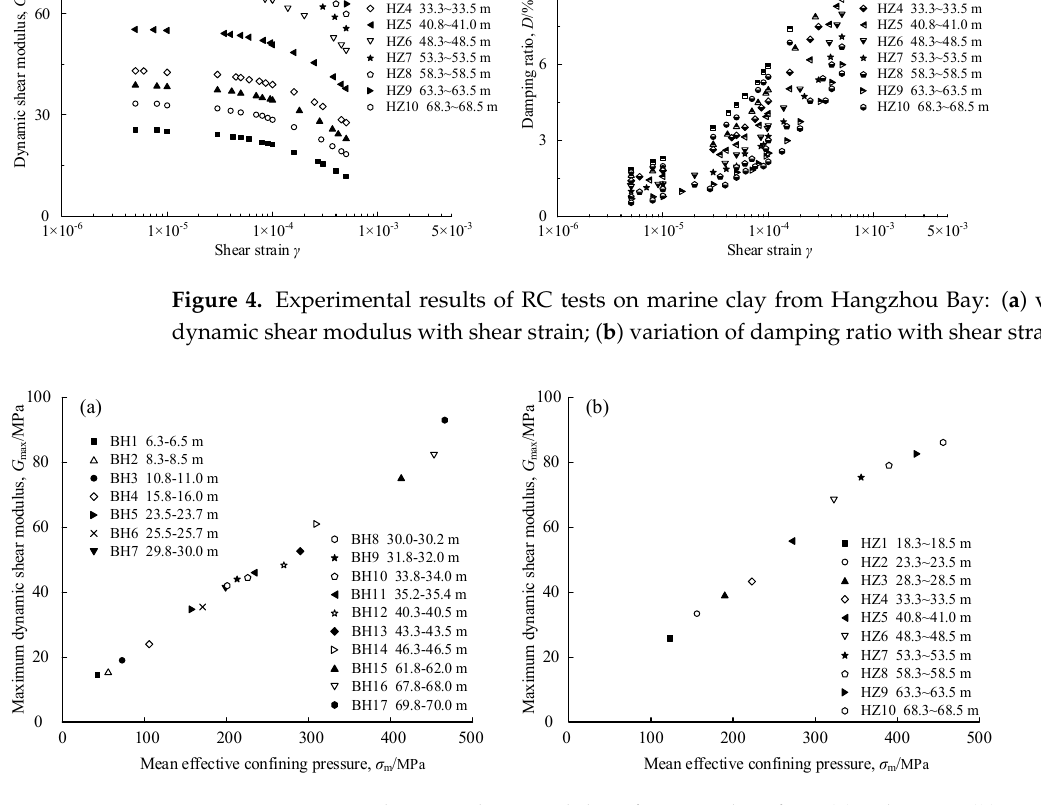
Figure 5. Maximum dynamic shear modulus of marine clays from ( a ) Bohai Bay; ( b ) Hangzhou Bay.